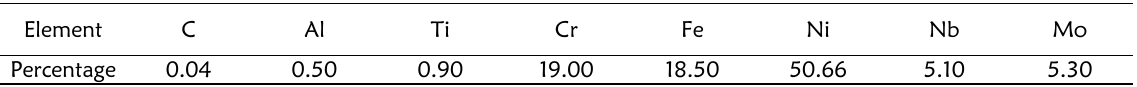
Table 2: Chemical composition of Inconel 718